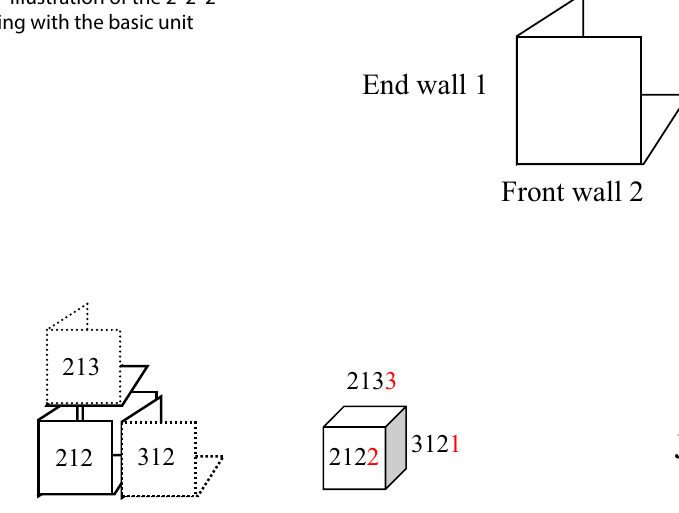
Fig. 7 Illustration of the 2*2*2 building with the basic unit